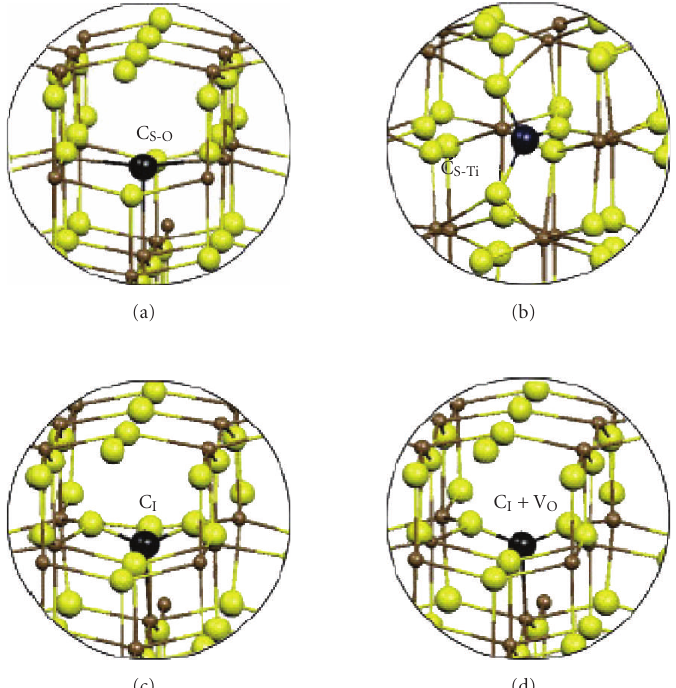
Figure 3: Partial geometry of the models for: (a) one substitutional C atom to O (C S − O ), (b) one substitutional C atom Ti (C S − Ti ), (c) one interstitial C atom (C I ), and (d) one interstitial C atom nearby an oxygen vacancy (C I + V O ) in the anatase TiO 2 supercell; the yellow spheres represent O atoms, the small brown spheres represent Ti atoms, and the black represents the carbon